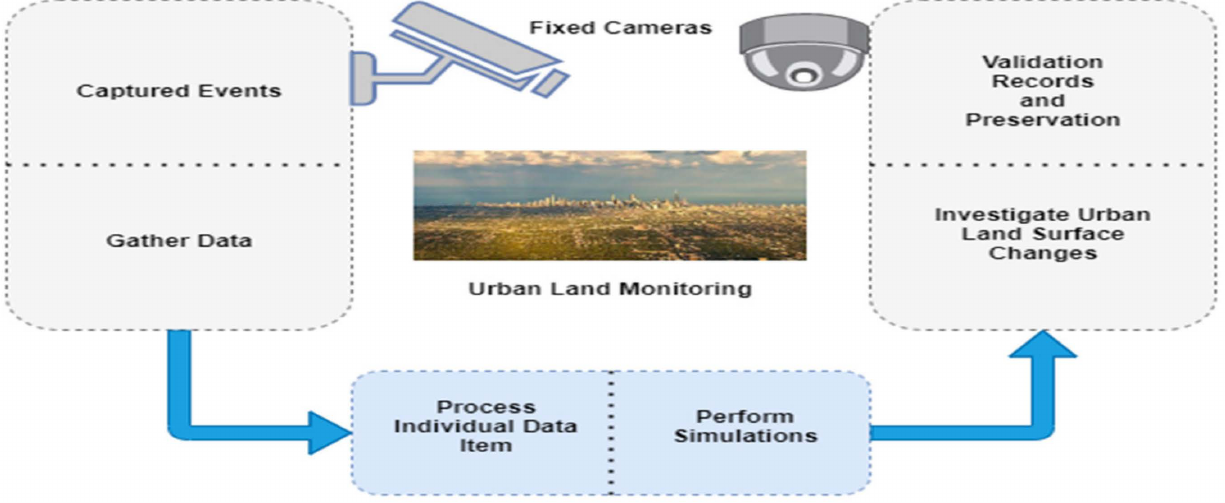
Figure 1. Existing Process of Urban Land Surface Monitoring